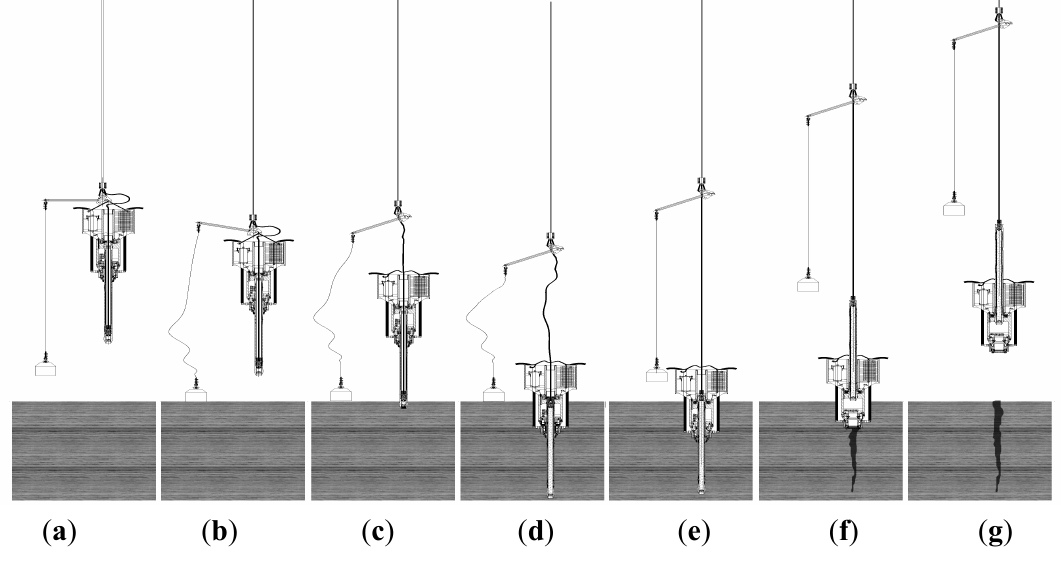
Figure 2. Operation of the long pressure-retained gravity-piston corer: ( a ) descent; ( b ) releasing; ( c ) fall; ( d ) penetration; ( e ) core head and pressure chamber free; ( f ) retraction and initial lift; and ( g )